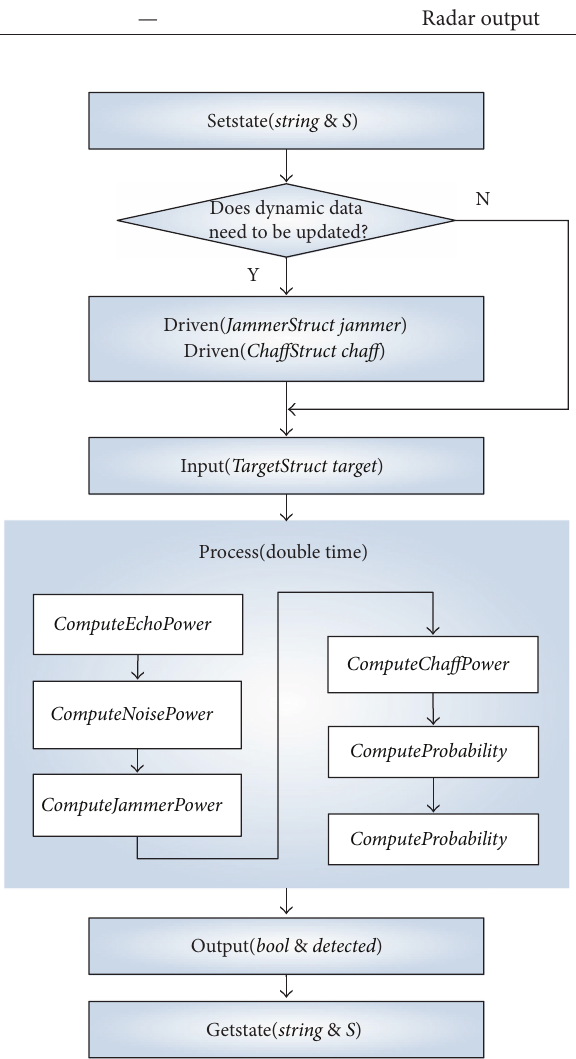
Figure 8: Reusable radar model execution